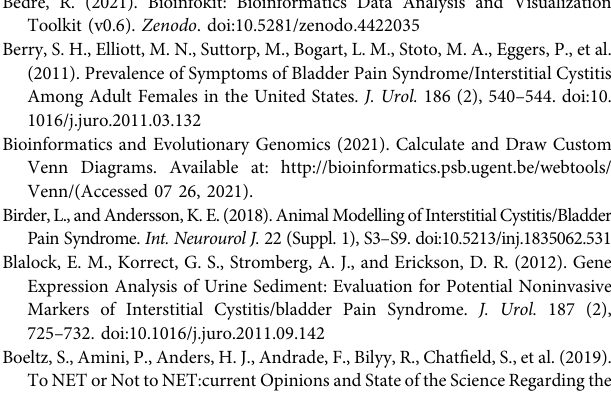
Supplementary Figure S3 | The heat maps of each dataset for the HLD vs. Ctrl comparison. Each square represents a probeset ( y -axis) for each sample ( x -axis). Red and blue colors represent upregulation and downregulation, respectively, whereas the white color represents no change in expression levels. Samples in the black boxes are patients corresponding to the HLD group in each